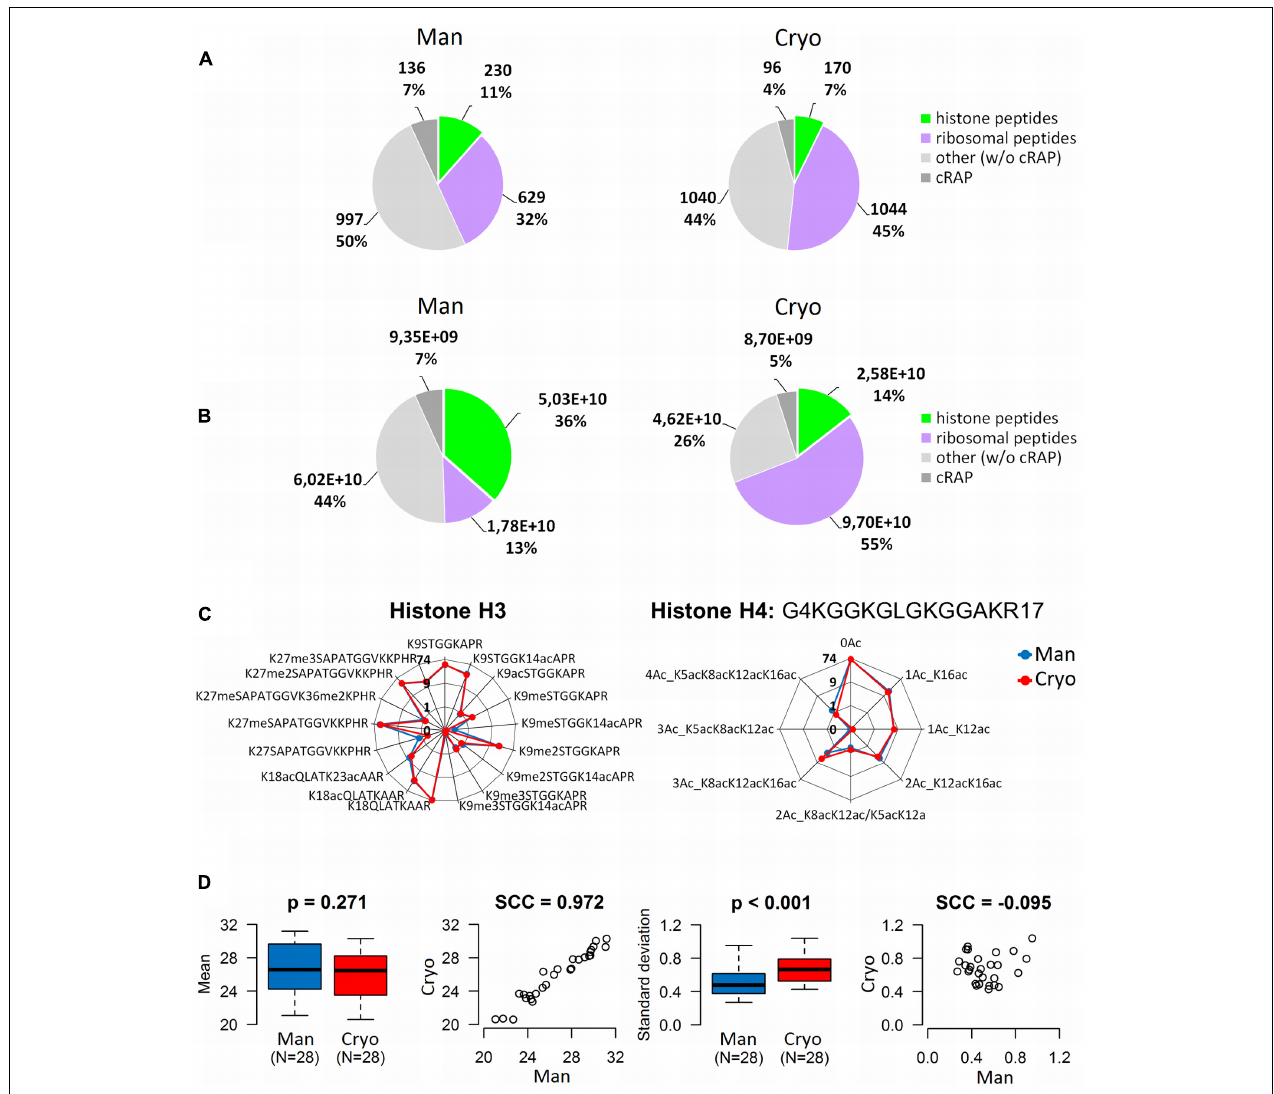
FIGURE 4 | Comparison of the quality of histone peptides obtained by manual plant tissue homogenization (Man) and using a cryomill (Cryo). Differences in qualitative (A) and quantitative (B) distributions of identified peptides (merged data, N = 3). (C) Radar charts showing RAs of histone H3 and H4 peptide forms (ratios of XIC peak areas of peptides with given PTMs to the sum of peak areas of all forms of H3 or H4 peptides, respectively, in percentages). Y -values are binary logarithms, with zero at the center of each chart. (D) Box-plots and scatter-plots of the means and standard deviations of abundances of histone H3 and H4 peptide forms detected in the samples. The boxplots show extremes, interquartile ranges and medians ( N = 28). Means and standard deviations were compared by Mann–Whitney tests ( p -values) and calculating Spearman’s correlation coefficients (SCC